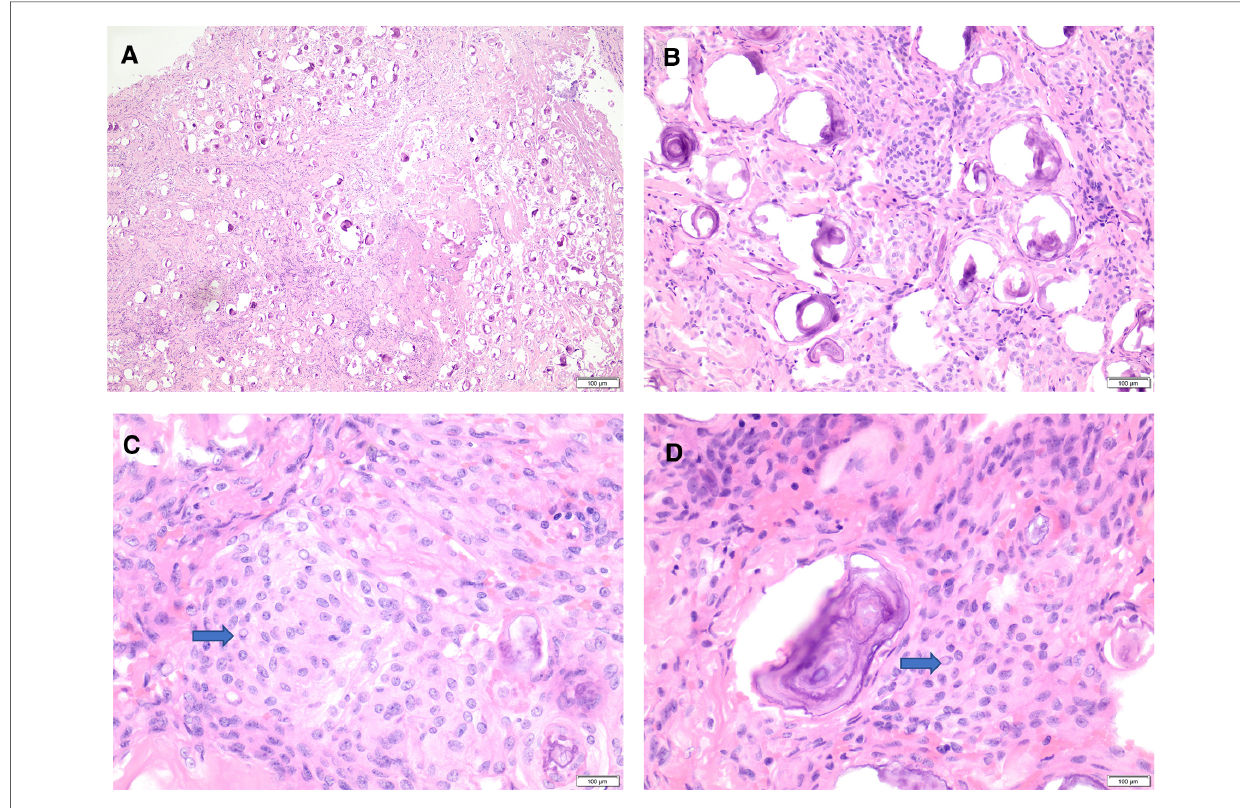
FIGURE 4 Histomorphology of psammomatous meningioma. ( A,B ) H&E stain showing meningothelial neoplasm with prominent psammomatous calci fi cations ( A : 20×, B: 40×). ( C,D ) H&E stain reveals meningothelial cells featuring whorls, frequent intranuclear pseudo-inclusions (blue arrows), and some nuclear holes (40×). H&E, hematoxylin and eosin